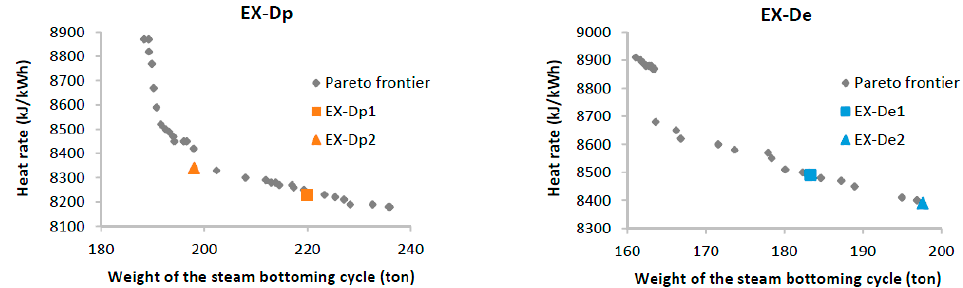
Figure A6. Pareto frontiers of extraction steam turbine cycle for case D at peak (EX-Dp) and end-life (EX-De) conditions.